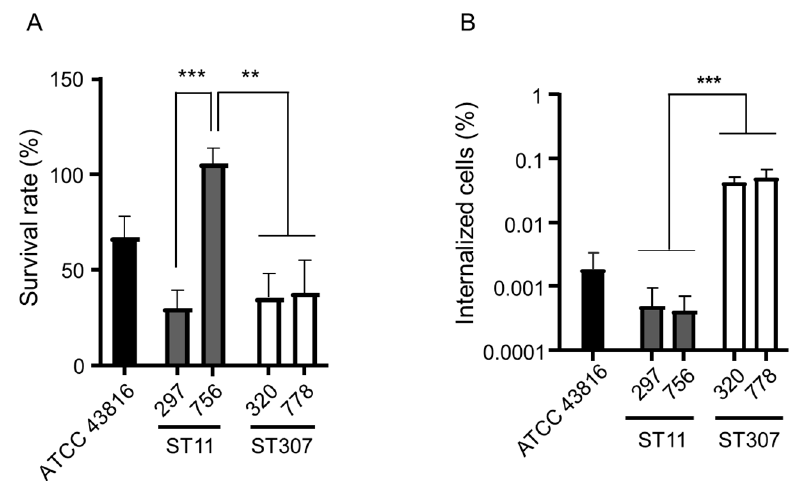
Figure 2. Virulence of the isolates of the two main clones of KP-Kp—ST11 and ST307. ( A ) The result of the serum resistance assay. The survival rate of K. pneumoniae isolates was determined after 3 h of incubation with human serum. Heat-inactivated serum was used as a negative control. ( B ) The result of the macrophage infection assay. The number of internalized bacteria recovered from J774A.1 cells was enumerated. ** p < 0.001; *** p < 0.0001.